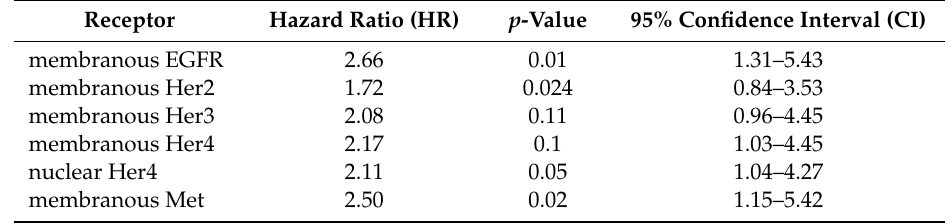
Table 5. Prognostic factors on five-year disease-free survival from the multivariate cox regression analysis (adjustment for p16 and UICC